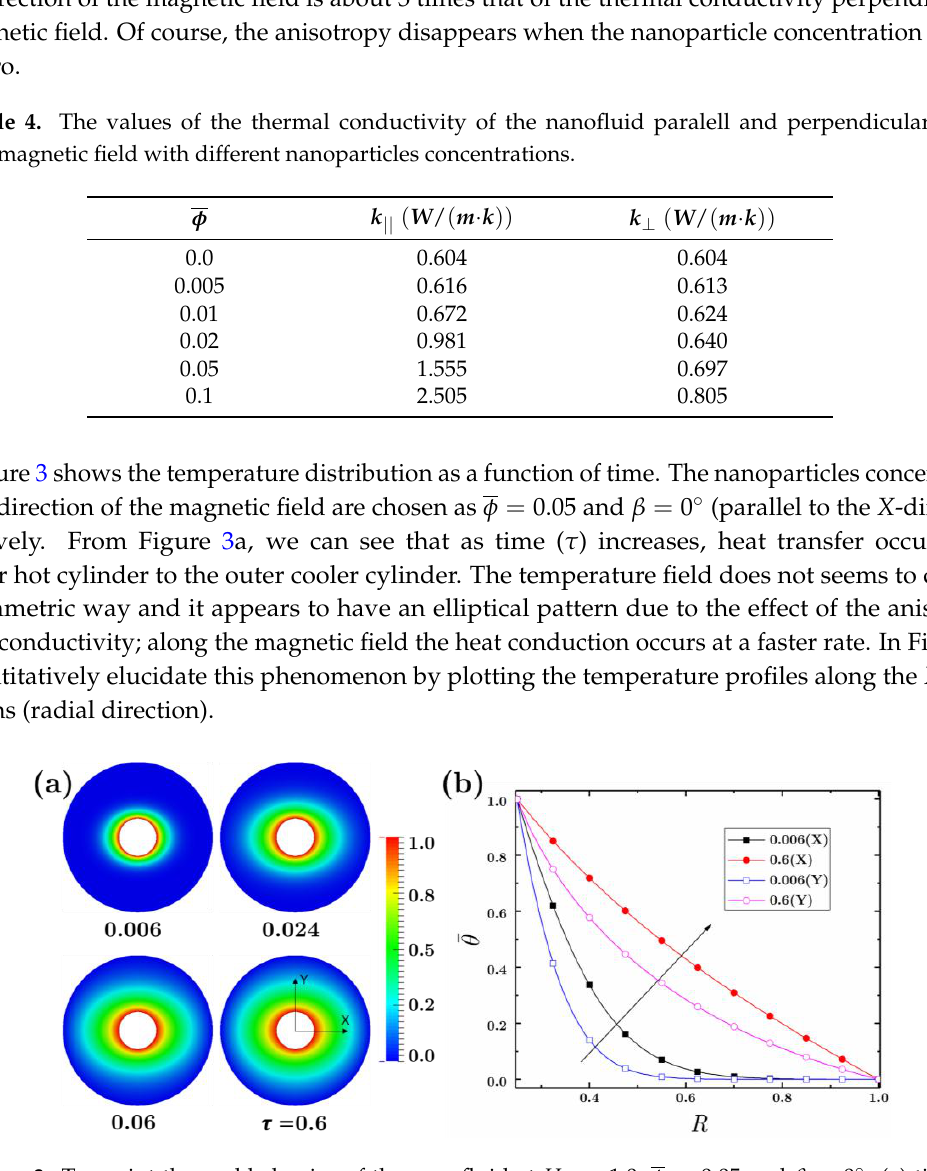
Figure 3. Transeint thermal behavior of the nanofluid at 𝐻𝑎 = 1.0 , 𝜙̅ = 0.05 and 𝛽 = 0° : ( a ) time evolution of the temperature field between two concentric cylinders; ( b ) temperature profiles along X and Y directions at two different dimensionless time ( 𝜏 ).